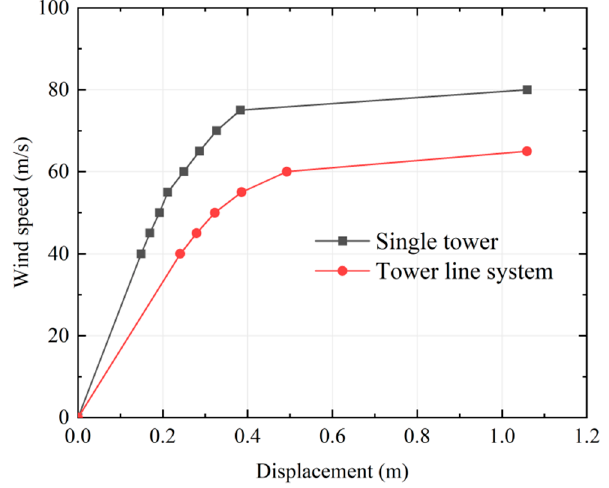
Figure 17. Relationship between structural characteristic response and corresponding wind speed.